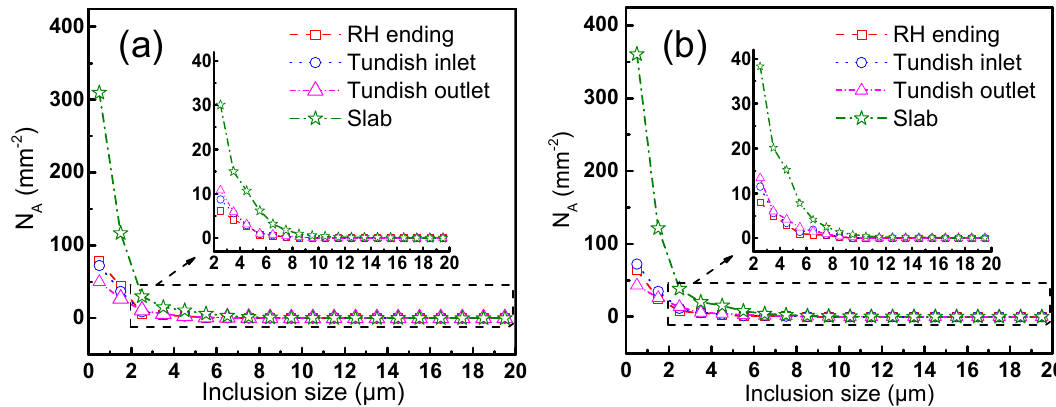
Figure 9. PSD (Particle Size Distribution) of inclusions at the different steelmaking stages for Steels ( a ) A and ( b ) B.